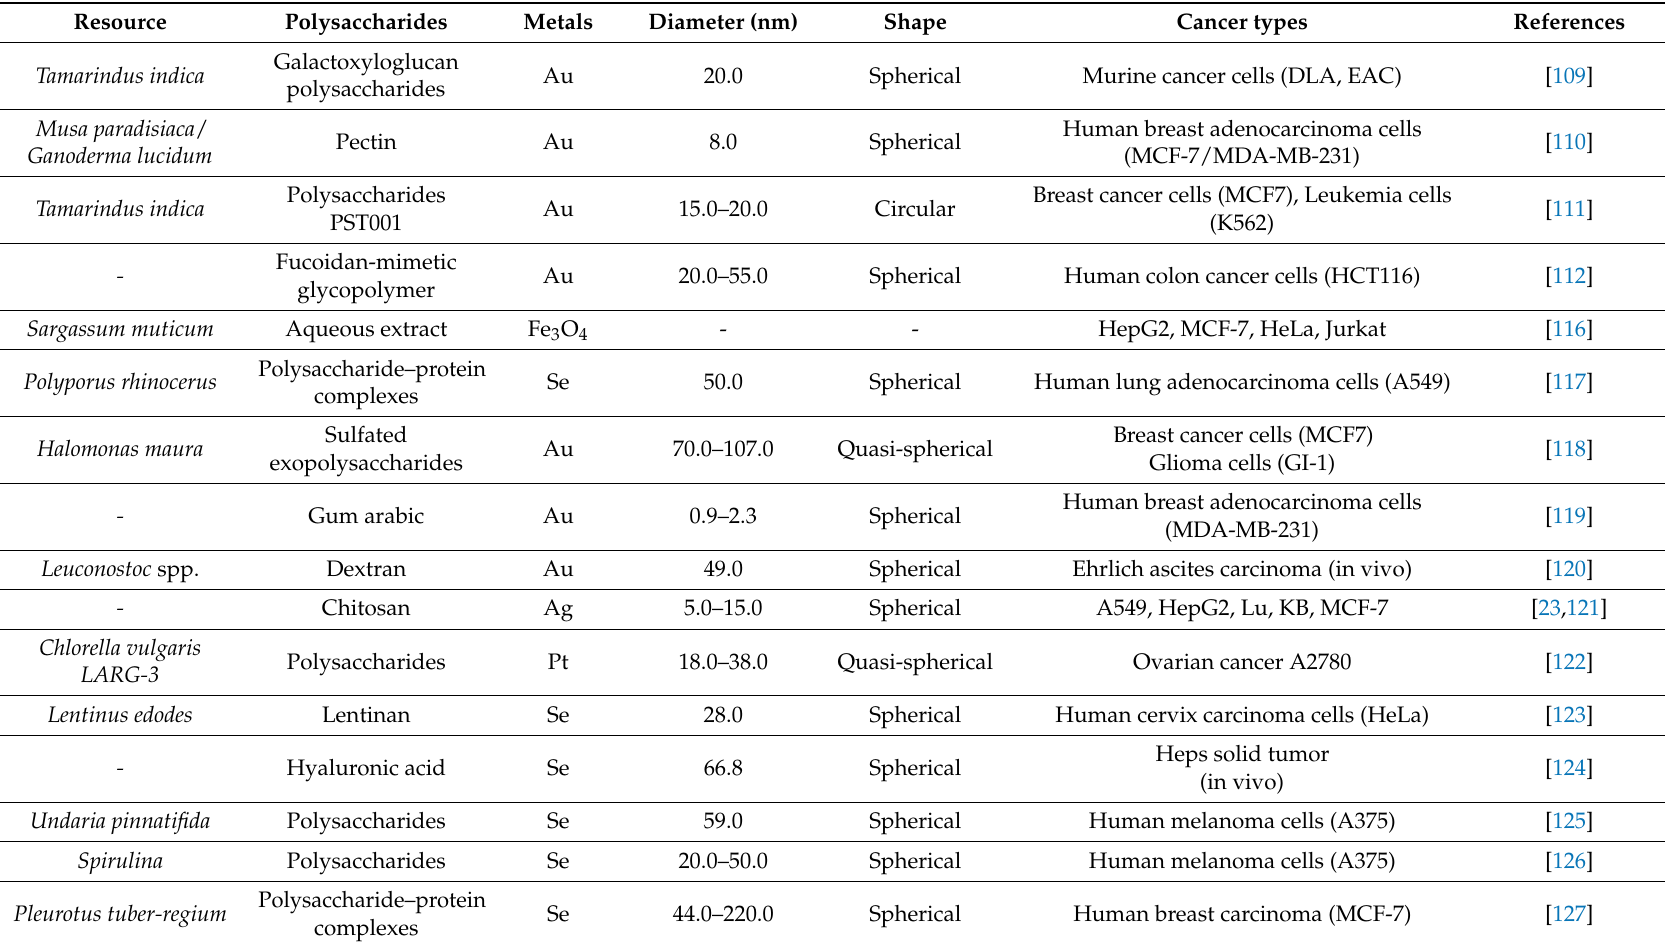
Table 2. Summary of literature data regarding the anticancer property of